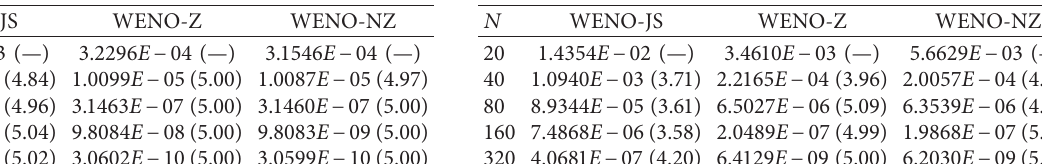
Table 1: L errors and convergence order on Case 1: 1D scalar ∞ convection equation with initial condition (59).